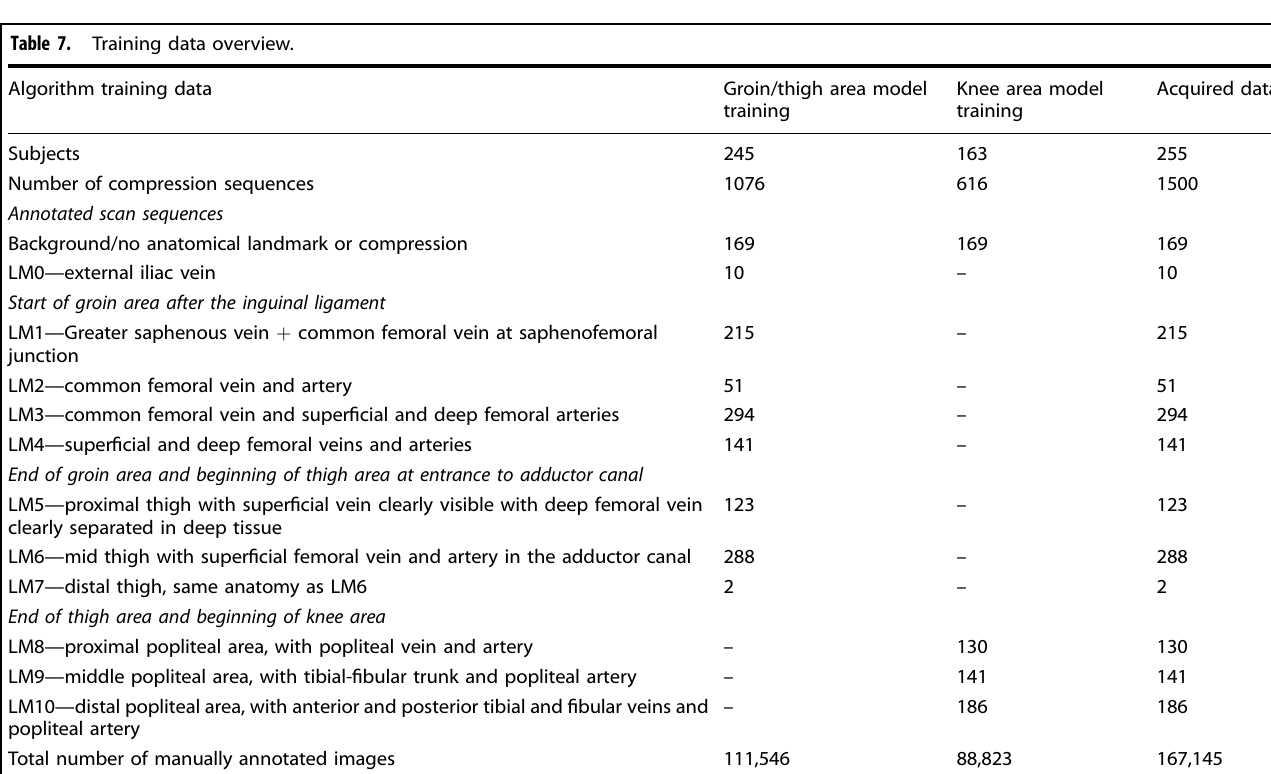
Table 7. Training data